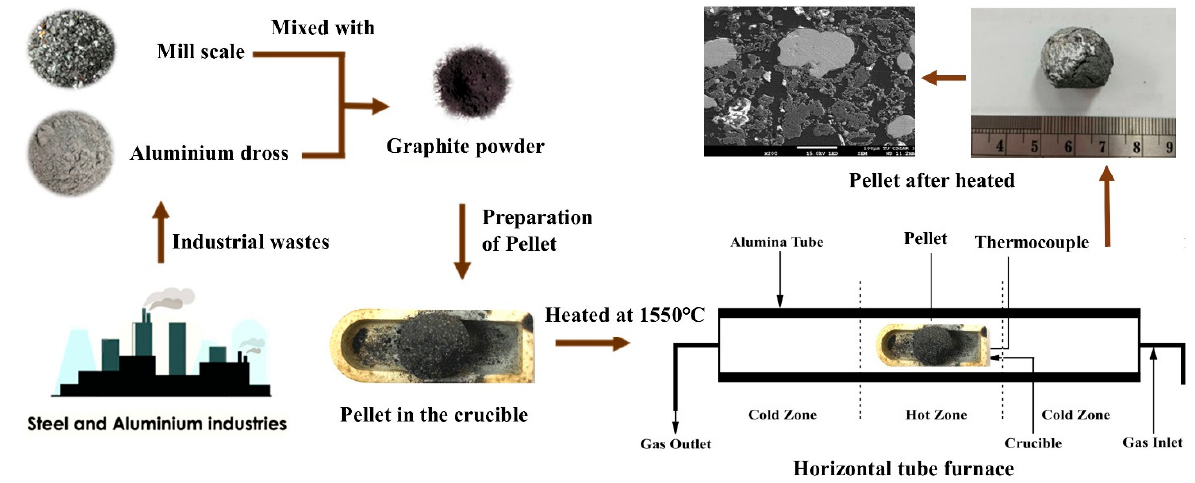
Figure 1. Overview of samples preparation and experimental procedure .